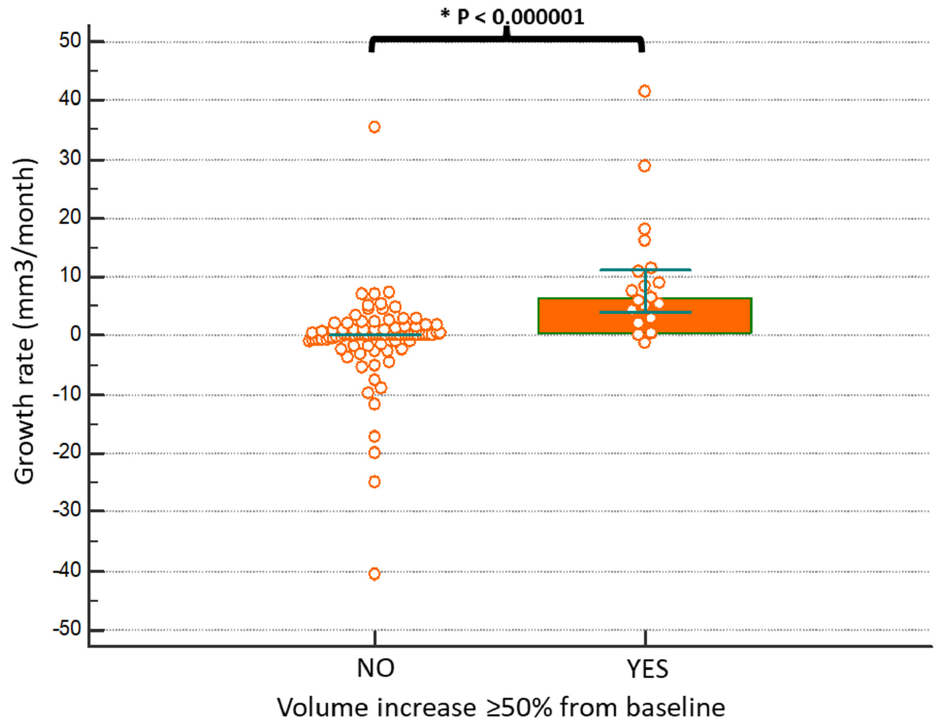
Figure 2. Patients who had a volumetric change in mPTC greater than 50% compared to baseline at the last check-up showed a greater speed of growth (6.56 versus 0 mm 3 /month).